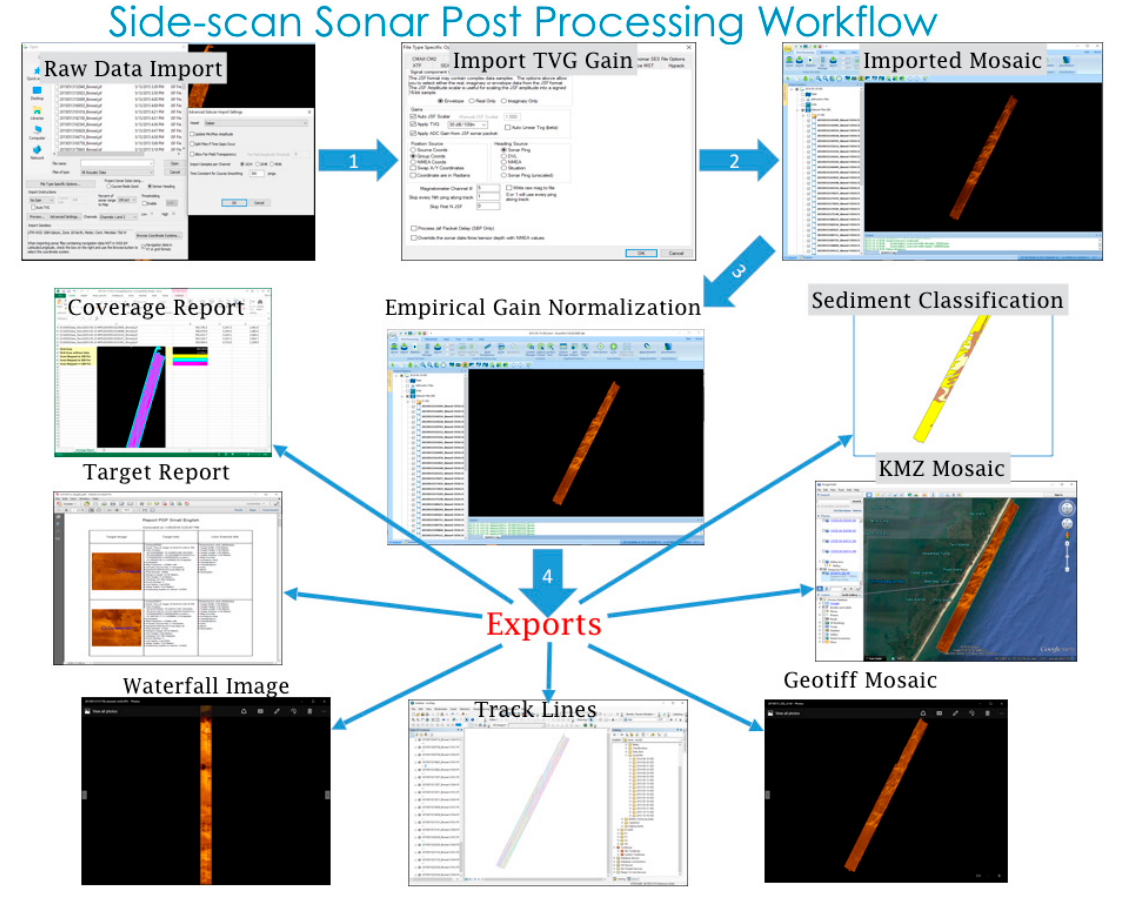
Figure 3. Side-scan sonar post processing workflow used by the University of Delaware, Assateague Island National Seashore mapping project: from EdgeTech raw data to SonarWiz to shapefiles and Google Earth .kml data products.